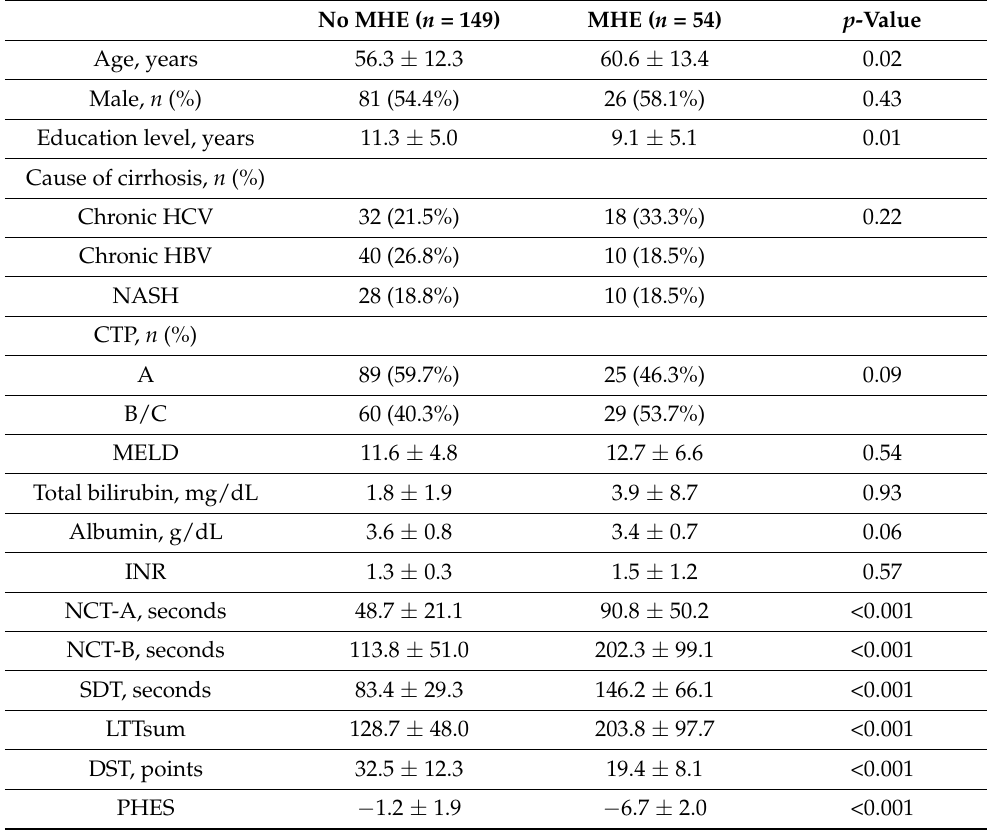
Table 4. PHES and individual test scores and variables related to MHE in cirrhotic patients with and without